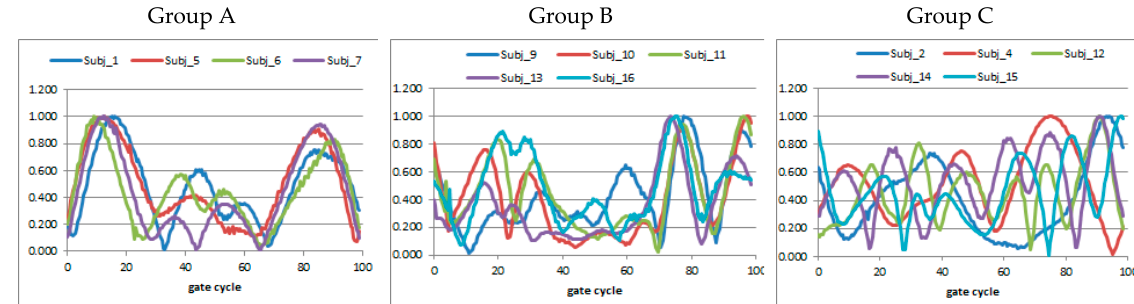
Figure 5. Ankle EP velocities of three groups categorized by correlation coefficient.